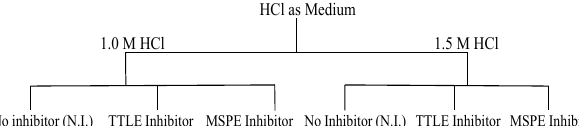
Fig. 1. Distribution of plants extracts in acidic media (TTLE: water Talinum triangulare leaf extract, MSPE: Musa sapientum extract, N.I.: No inhibitor).